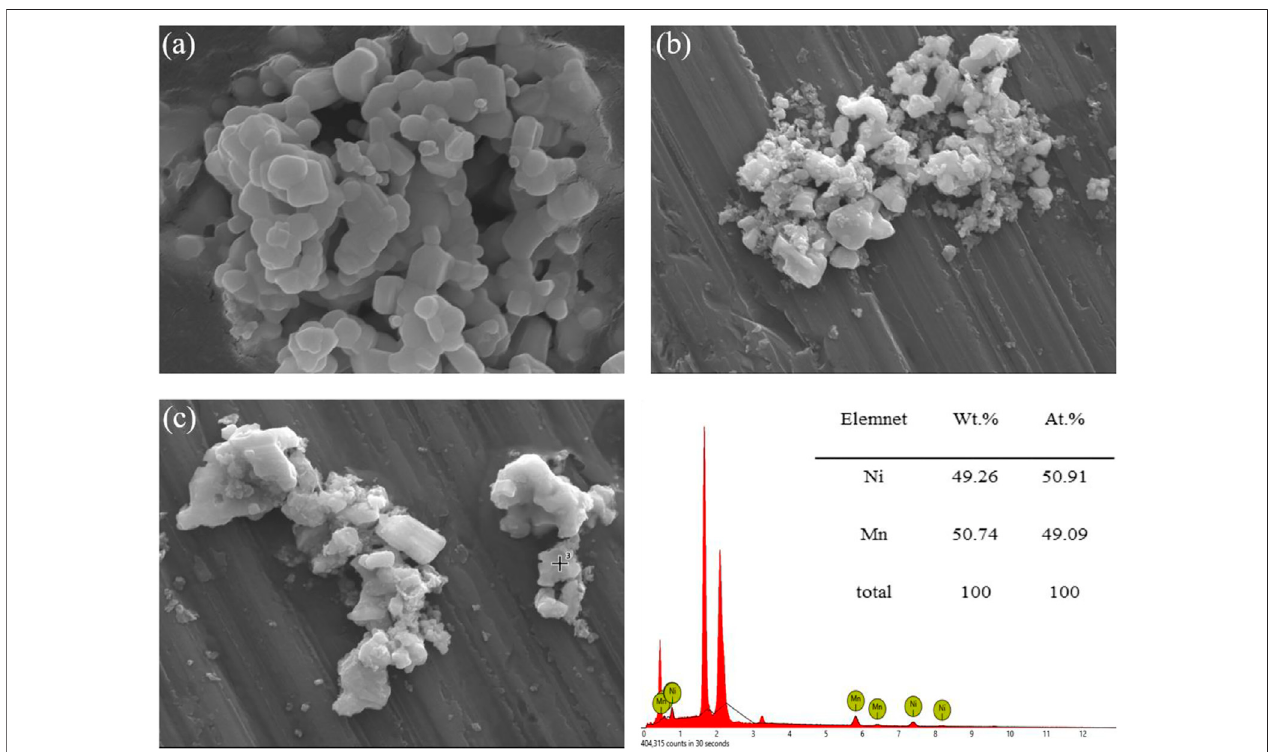
FIGURE 2 | SEM images of (A) 20000x Nb 2 O 5 , (B) 20000x and (C) 30000x 10Ni-10Mn/Nb 2 O 5